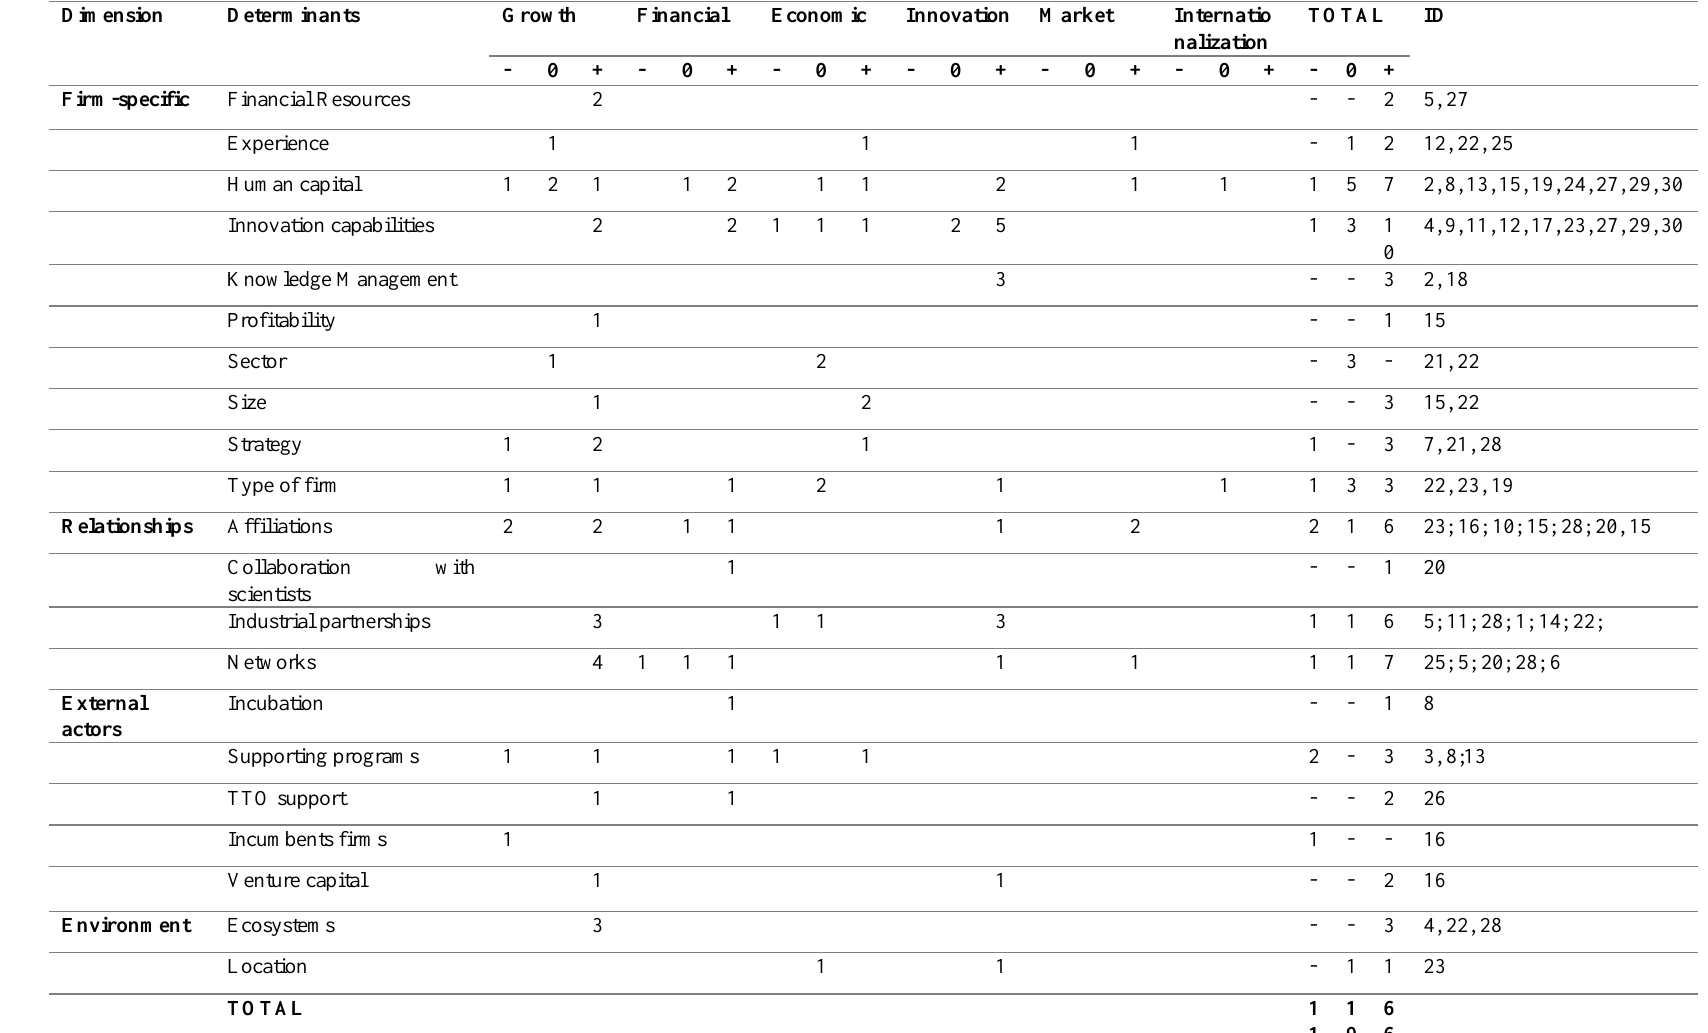
Table 3 : Variables